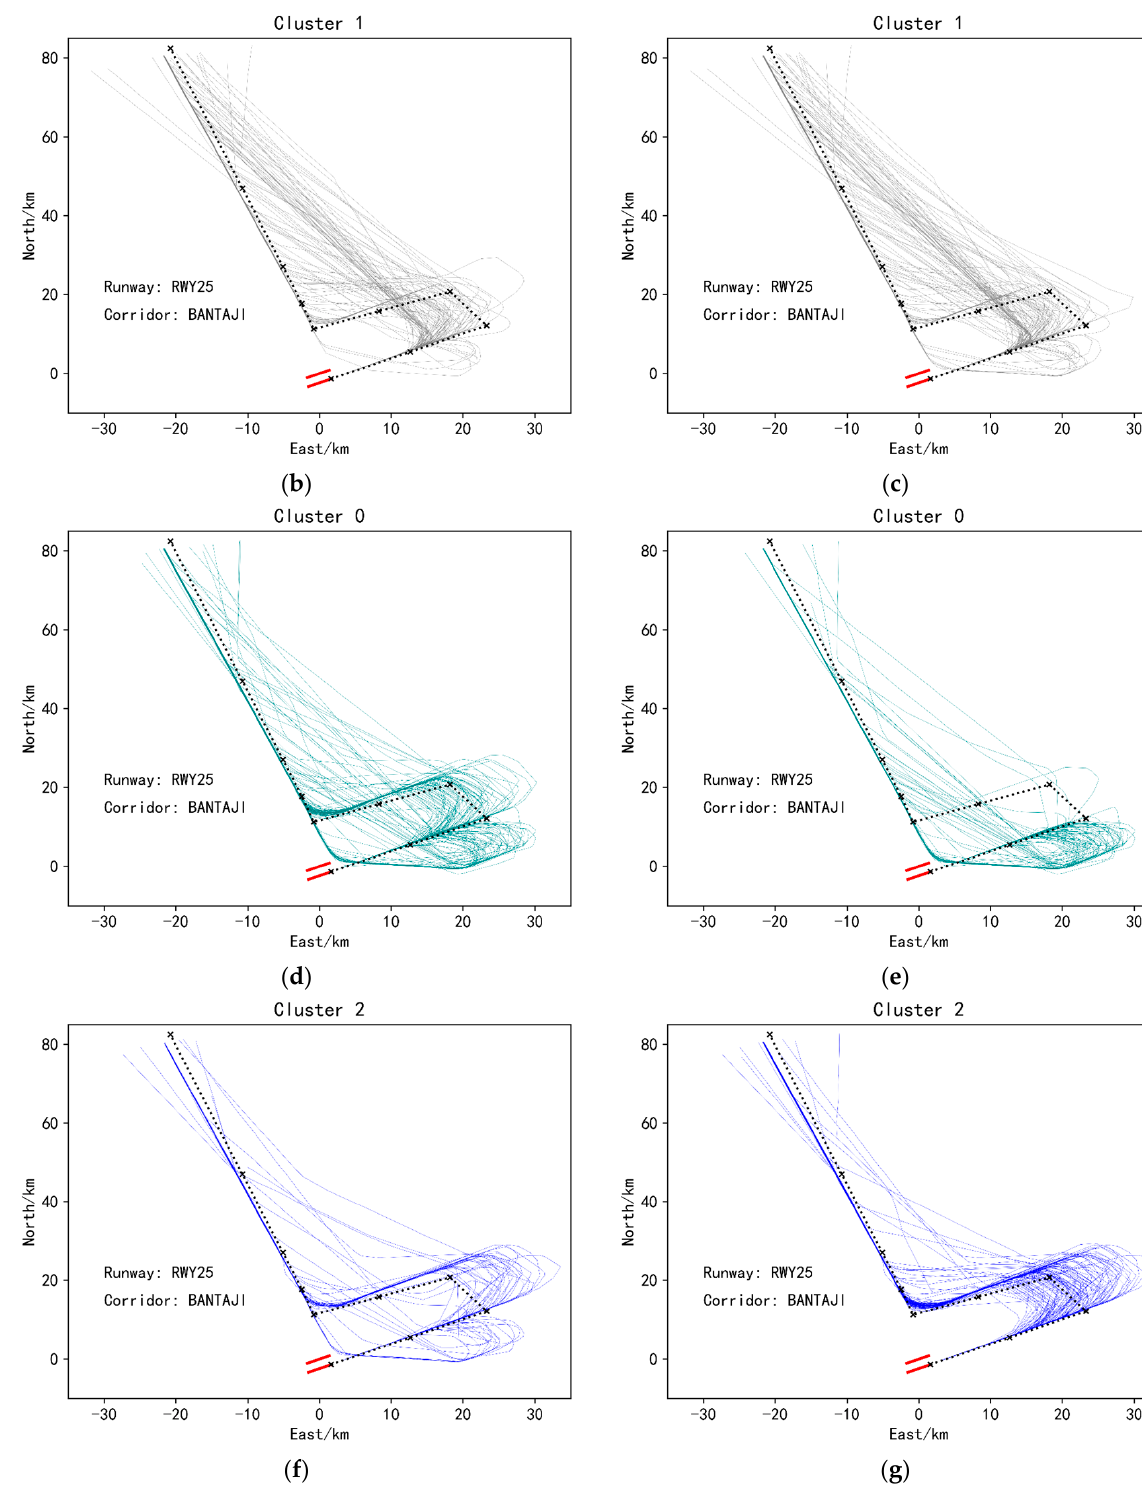
Figure 12. ( a ) Overall visualization of trajectories of runway25, corridor BANTAJI. ( b ) Cluster 1 trajectories under the single K-means clustering method. ( c ) Cluster 1 trajectories under ensemble K-means clustering method. ( d ) Cluster 0 trajectories under the single K-means clustering method. ( e ) Cluster 0 trajectories under ensemble K-means clustering method. ( f ) Cluster 2 trajectories under the single K-means clustering method. ( g ) Cluster 2 trajectories under ensemble K-means clustering method. Clustering results of landing trajectories of the BANTAJI corridor and Runway 25 under the single K-means clustering method and ensemble K-means method.